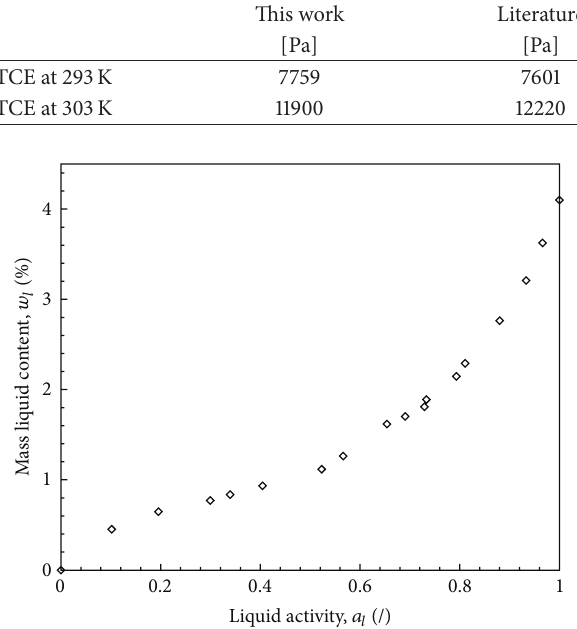
Figure3:SorptionisothermcurvesofTCEadsorbedinaclayeysilty sand determined with the activity